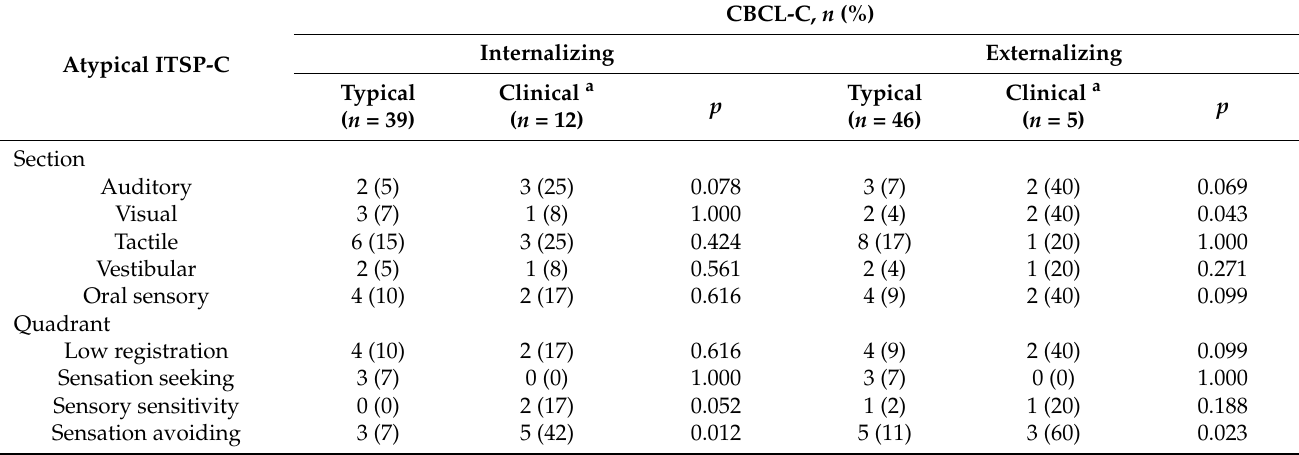
Table 4. The prevalence of atypical ITSP-C performance in term children with and without behavioral